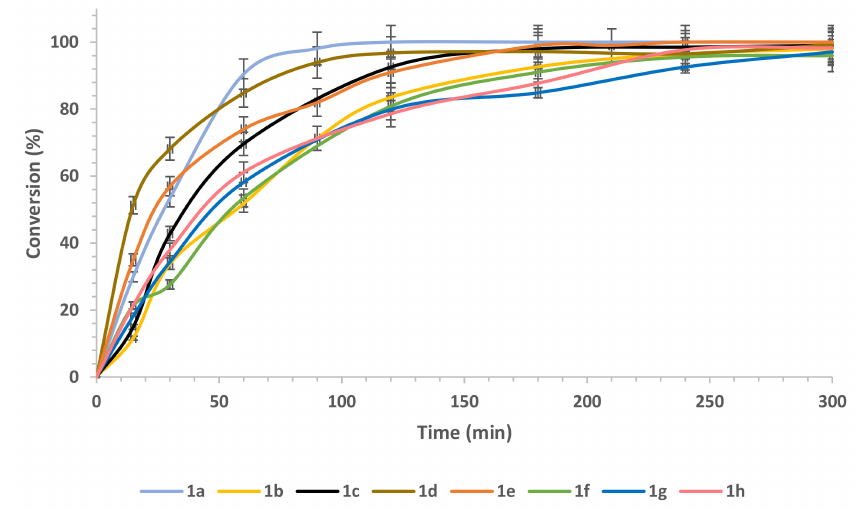
Figure 6. PSL catalysed transesterification reaction of 2 employing acyl donors with different chain